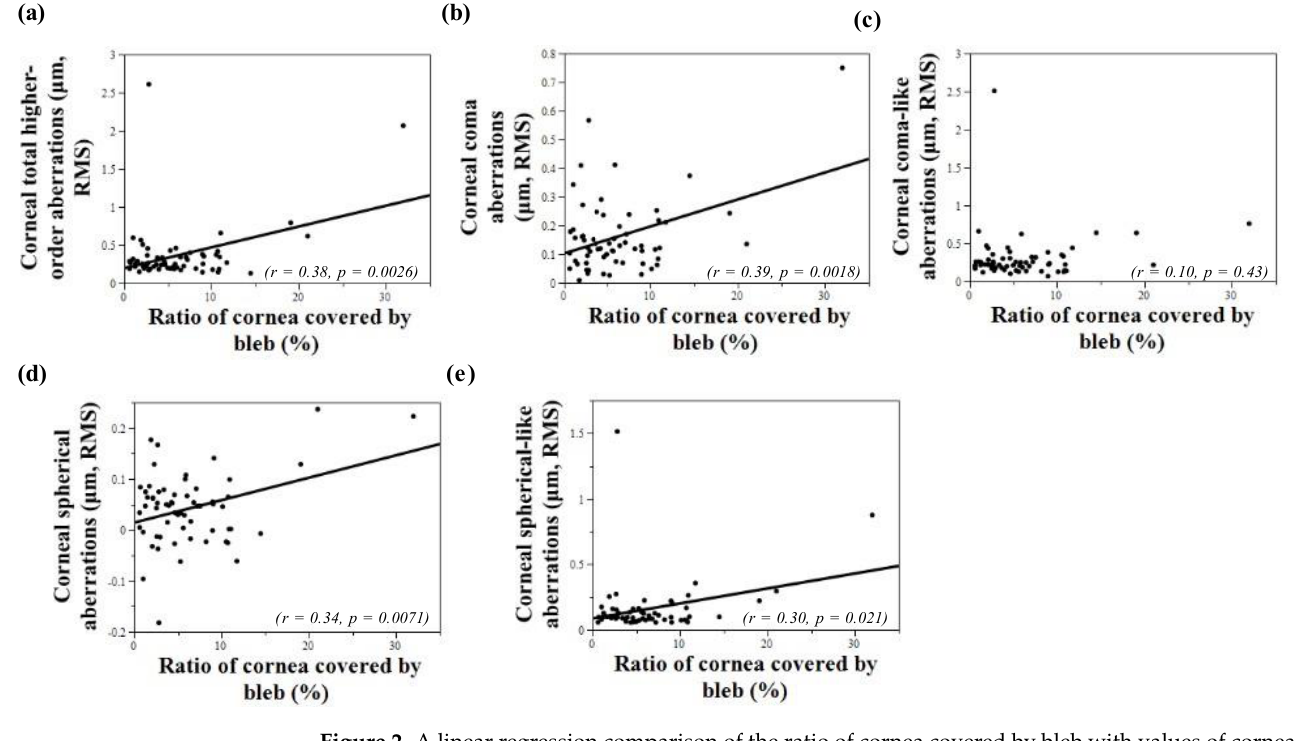
Figure 2. A linear regression comparison of the ratio of cornea covered by bleb with values of corneal higher-order aberrations (HOAs). ( a ) There is a positive correlation between the ratio of cornea covered by bleb and corneal total HOAs (r = 0.38; p = 0.0026). ( b ) There is a positive correlation between the ratio of cornea covered by bleb and corneal coma aberrations (r = 0.39; p = 0.0018). ( c ) Corneal coma-like aberrations showed no correlation between the ratio of cornea covered by bleb (r = 0.10; p = 0.43). ( d ) There is a positive correlation between the ratio of cornea covered by bleb and corneal spherical aberrations (r = 0.34; p = 0.0071). ( e ) There is a positive correlation between the ratio of cornea covered by bleb and corneal spherical-like aberrations (r = 0.30; p = 0.021). Univariate regression revealed a significant positive relationship between the ratio of cornea covered by bleb for corneal total HOAs, corneal coma aberrations, corneal spherical aberrations, and corneal spherical-like aberrations ( β = 0.38; p = 0.0026, β = 0.39; p = 0.0018, β = 0.34; p = 0.0071, β = 0.30; p = 0.02, respectively) (Table 4). Number of TLE surgeries tions ( β = 0.28; p = 0.027, β = 0.28; p = 0.026, respectively). Univariate regression analysis